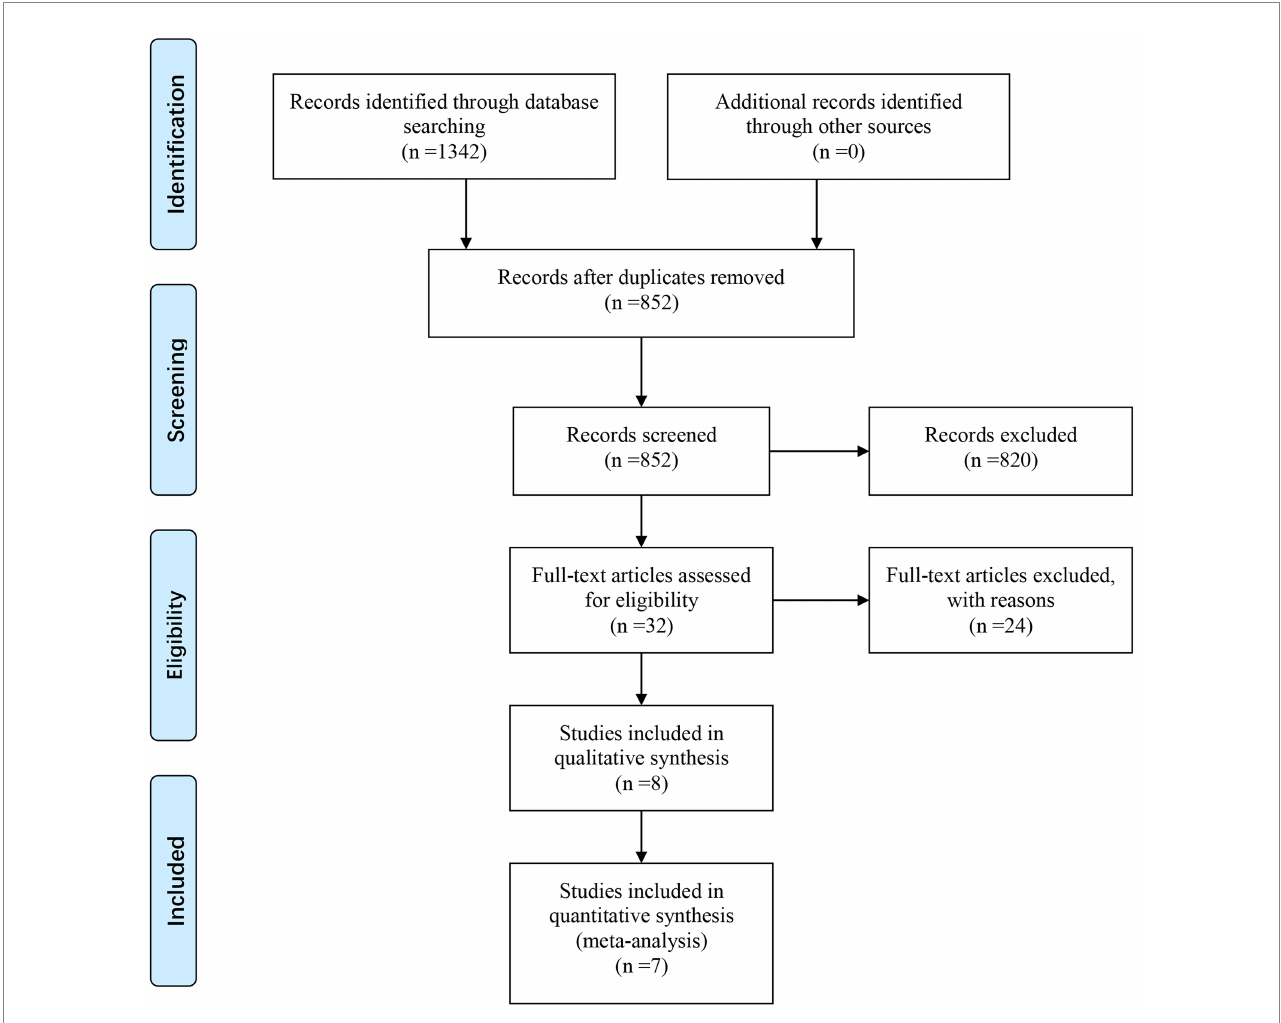
FIGURE 1 Flow diagram for search and selection of included